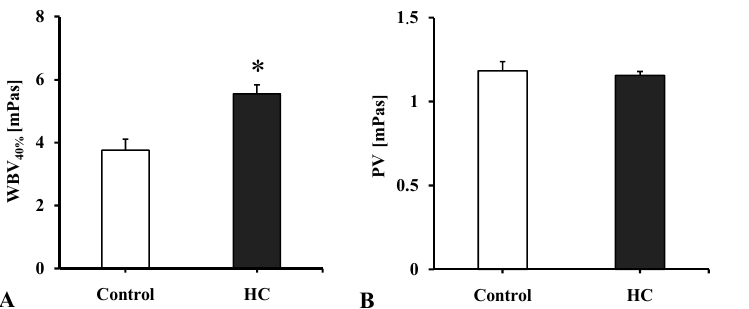
Figure 1. ( A ): whole blood viscosity corrected to 40% hematocrit (WBV [mPas]) and ( B ): plasma viscosity (PV [mPas]) values in the Control and the atherogenic groups (HC). Means ± SEM; * p < 0.05 vs. Control.